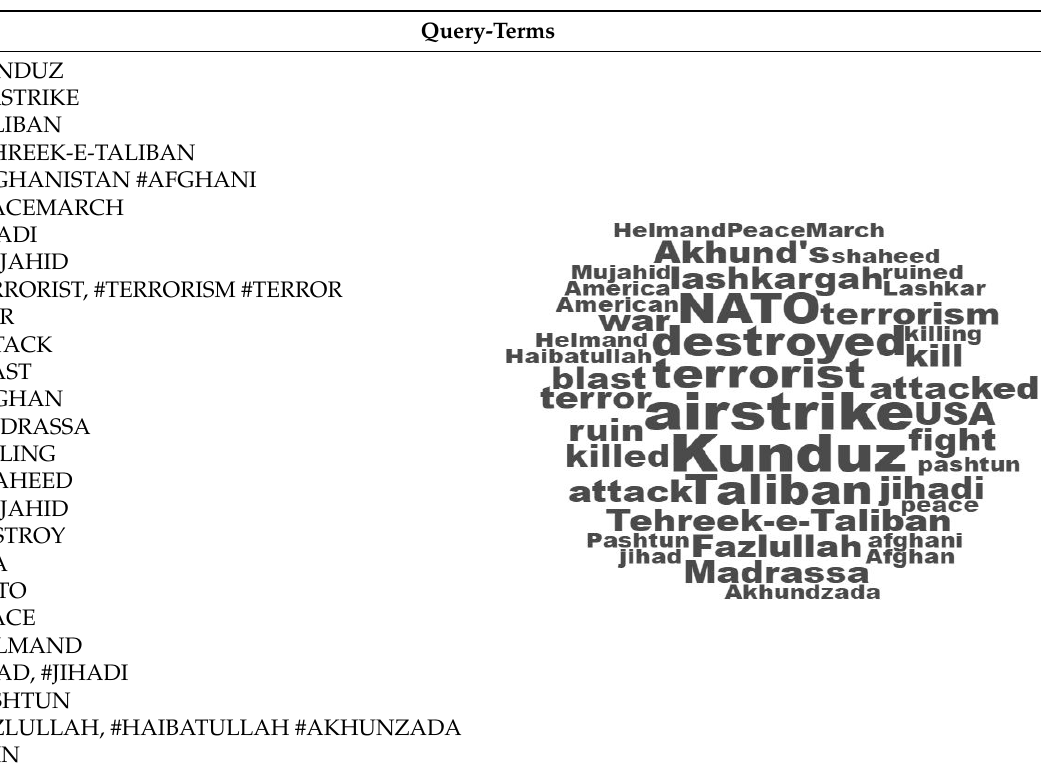
Table 2. Top trends used for data extractions.